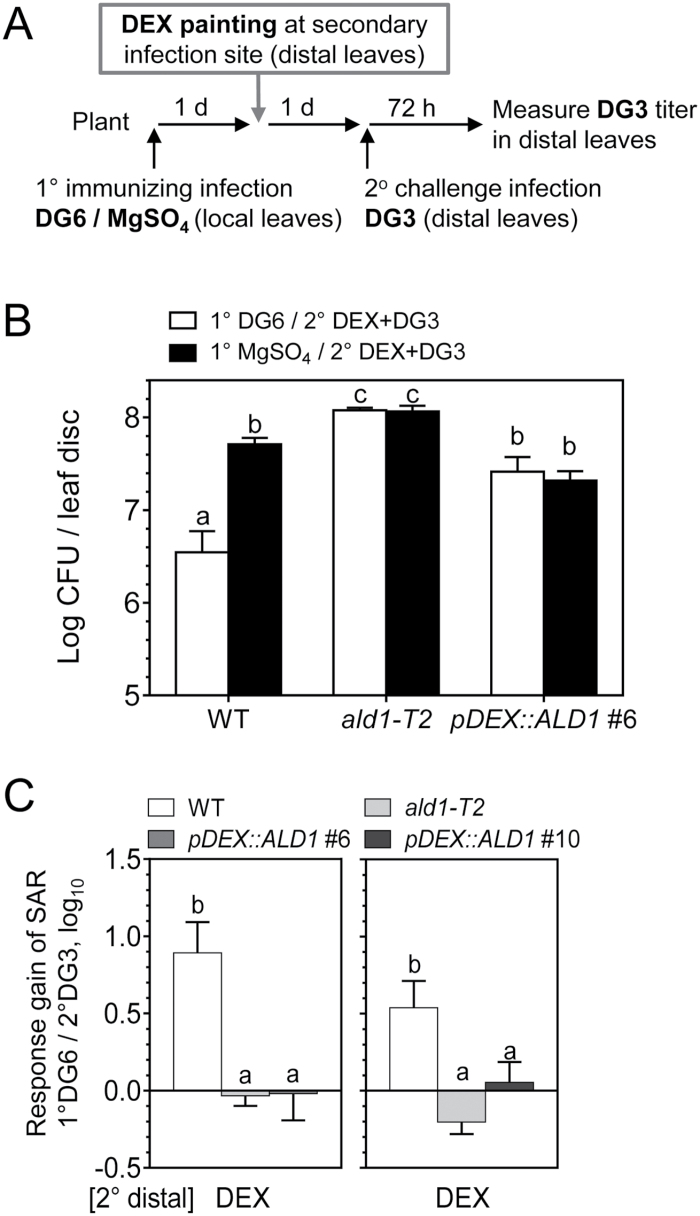
ALD1 accumulation at the 2° distal challenge site does not restore SAR. (A) Treatment scheme for specific expression of ALD1 at the 2° challenge infection site in SAR. Local leaves (the third to fifth leaves) were infiltrated with DG6 (OD600=0.01) or 10 mM MgSO4 during immunizing infection. Then distal leaves (the sixth to eighth leaves) were painted with DEX at 1 d prior to 2° challenge infection by DG3 (OD600=0.0001). The quantification of DG3 growth in distal leaves was measured 72 h later. (B) SAR response in distal leaves of the WT, ald1-T2, and pDEX::ALD1 #6 painted with 3 μM DEX. Growth of DG3 was measured in distal leaves. Error bars indicate the SEM from eight biological replicates. Another independent experiment with 15 μM DEX painting on distal leaves showed similar results. (C) Response gain of SAR in DEX-painted distal leaves due to 1° immunizing infection by DG6 (1° DG6/2° DG3). Results for pDEX::ALD1 #6 (left panel) and #10 (right panel) are each the average of two independent experiments. Different letters indicate statistically significant differences (P<0.05, ANOVA, Fisher’s LSD test).